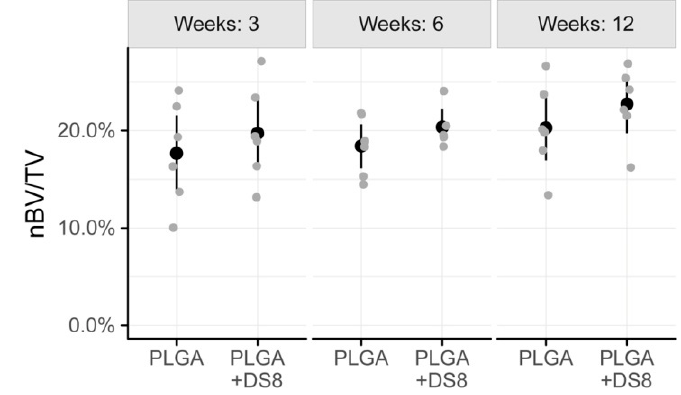
Figure 5. Scatter plot of nBV/TV, i.e., the percentage of newly formed bone volume (nBV) within the tissue volume (TV). (Black dots refer to mean values of the respective groups).